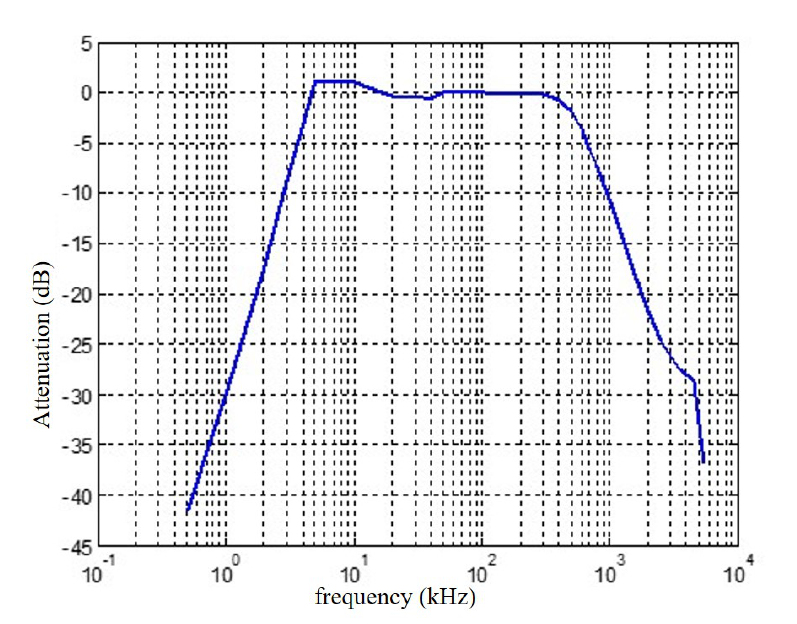
Figure 3. Transfer function of the coupling